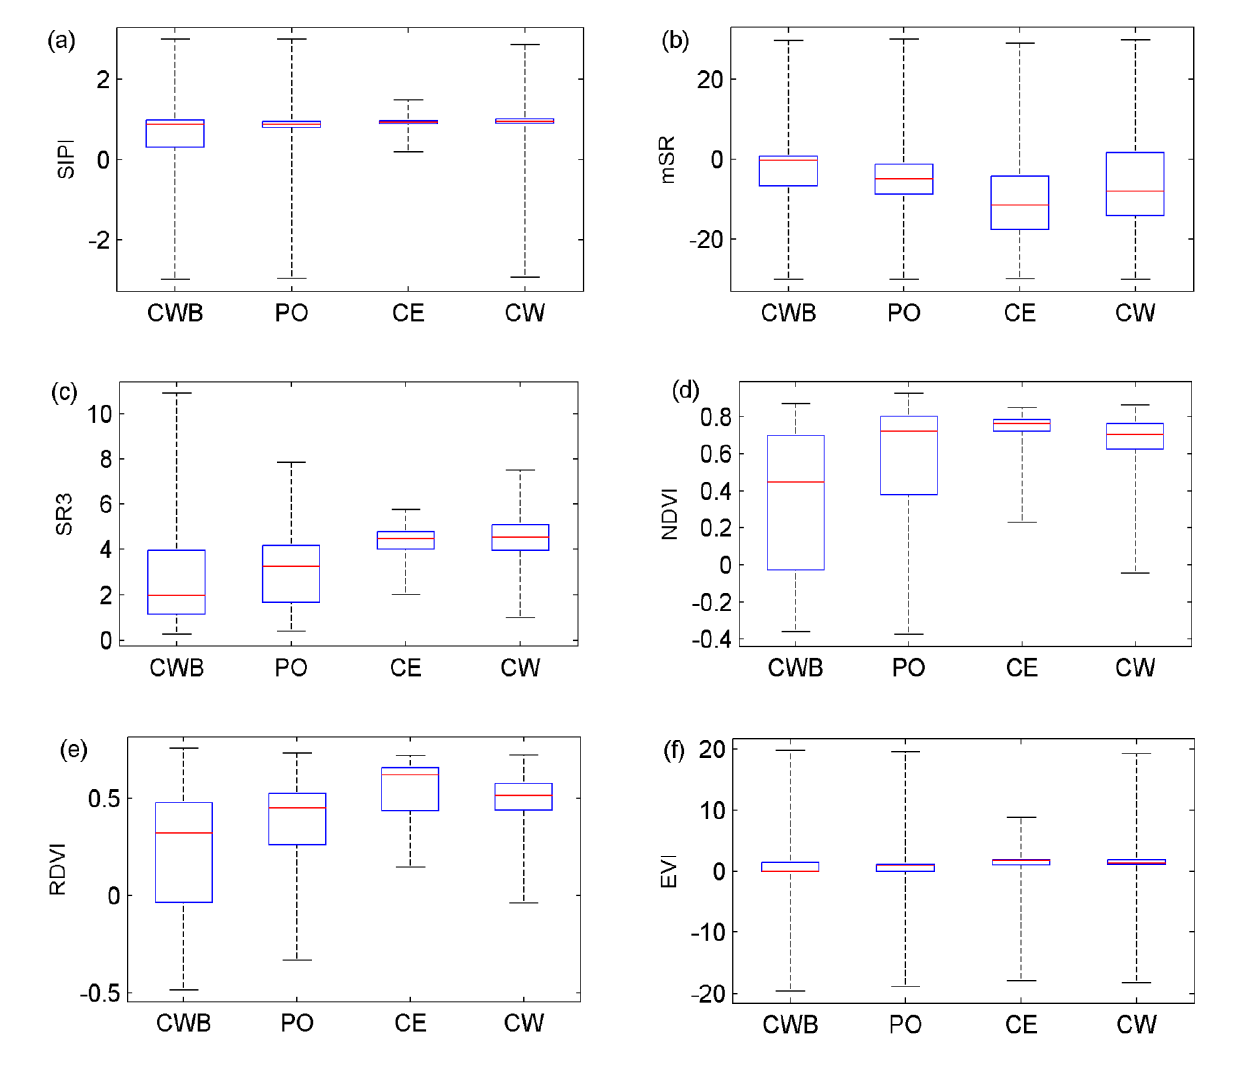
Figure 4. Boxplots of the VI values individually for the VI types of ( a ) SIPI; ( b )